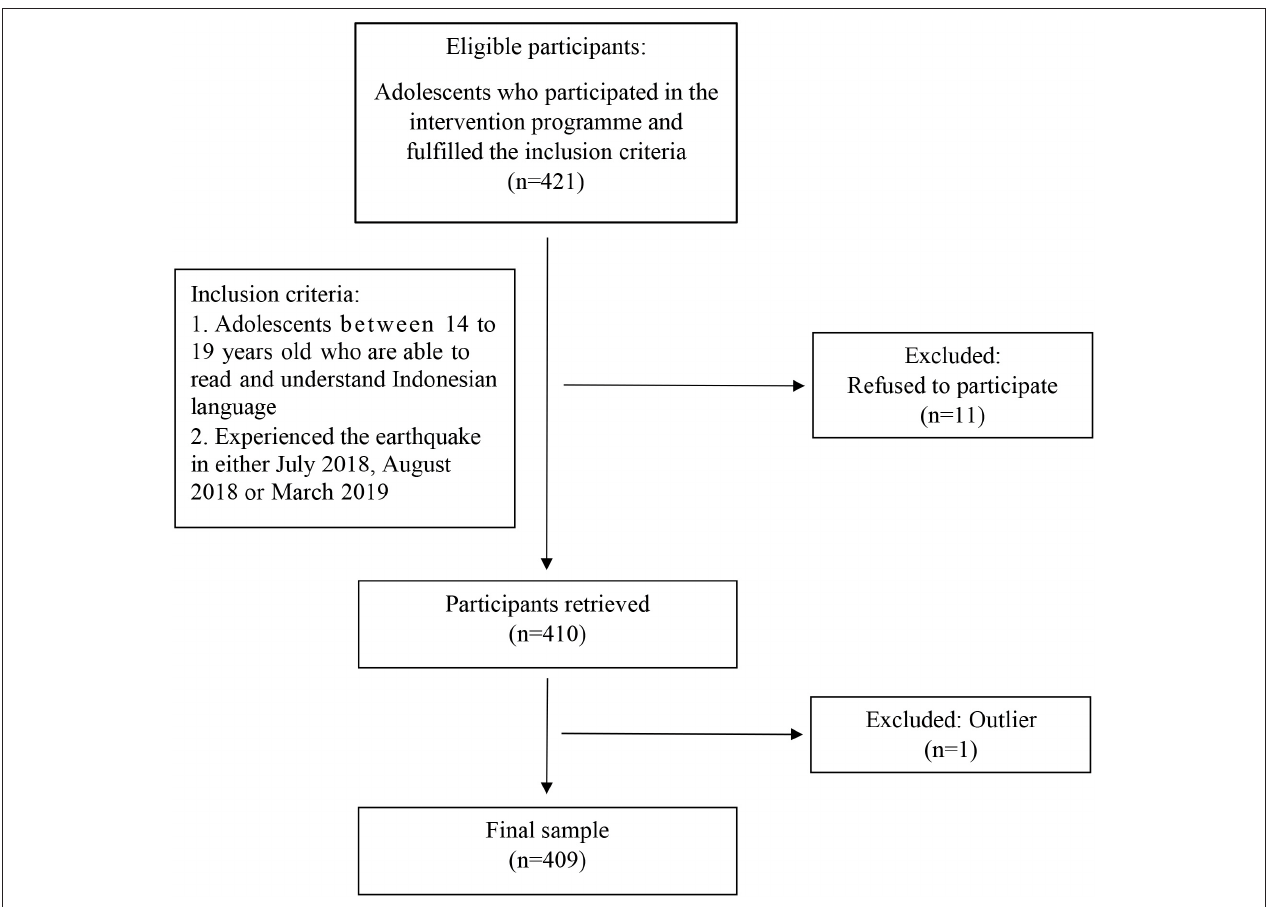
FIGURE 1 | Sampling process